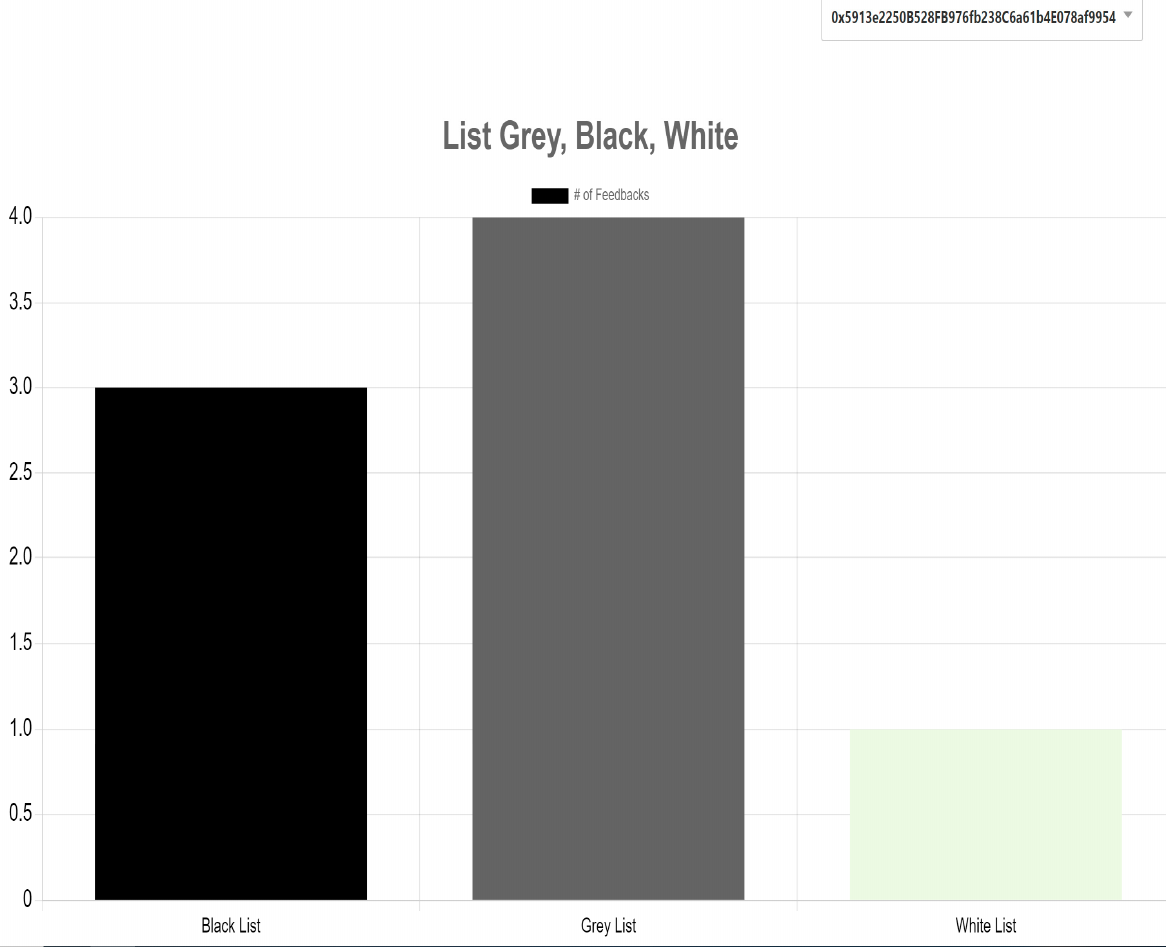
Figure 8. Variation in SP status based on the Reputation Values for SP1.